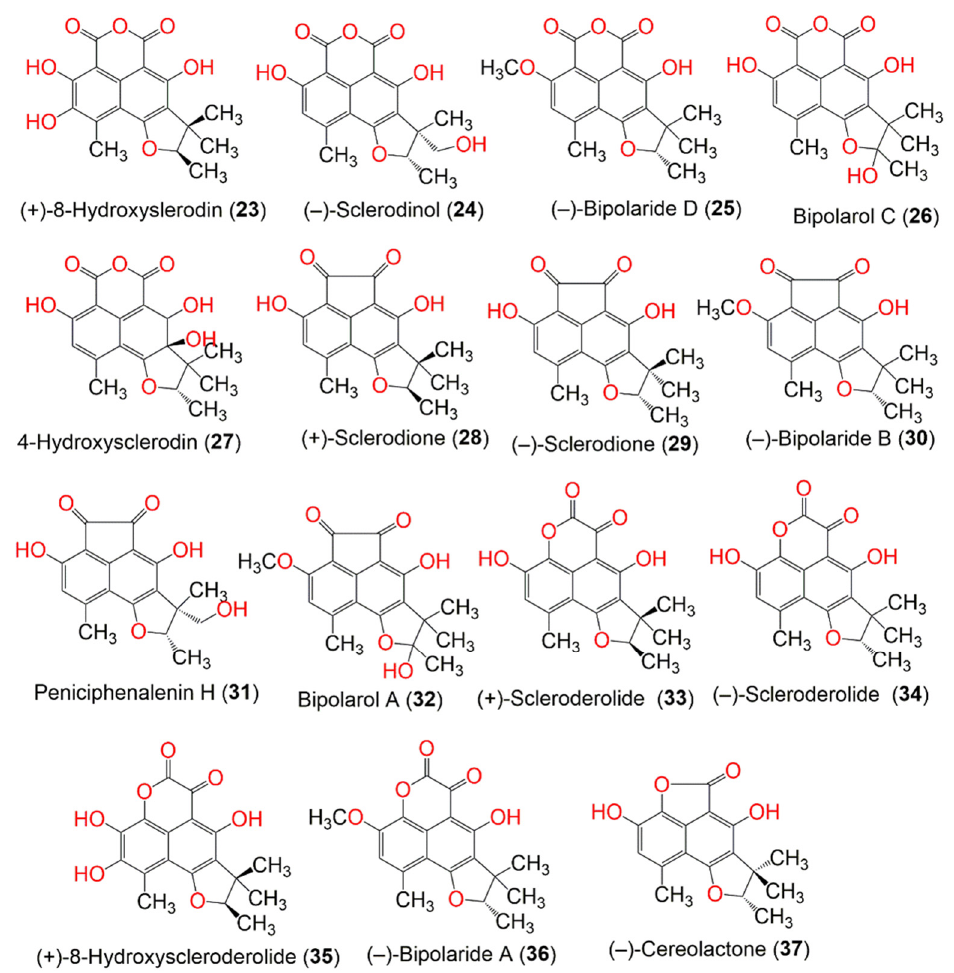
Figure 2. The structures of compounds 11–22 . Lee et al. purified 18 from a culture of Penicillium herquei FT729, derived from